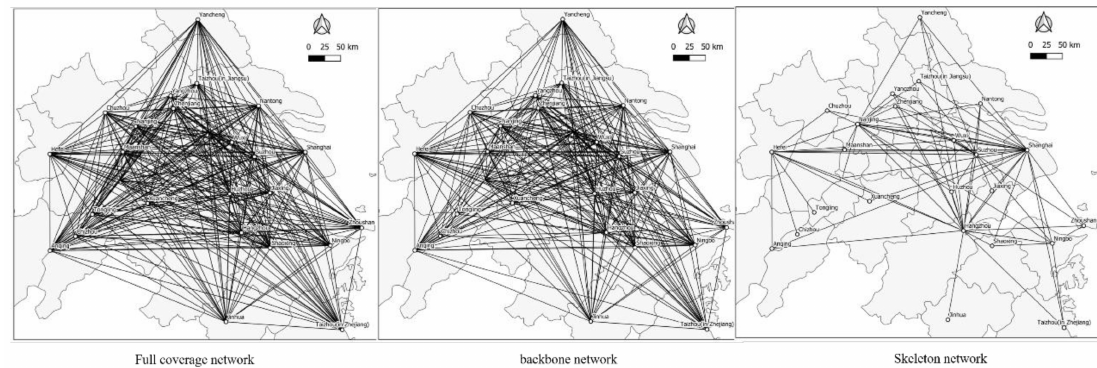
Figure 6. Information-flow network in